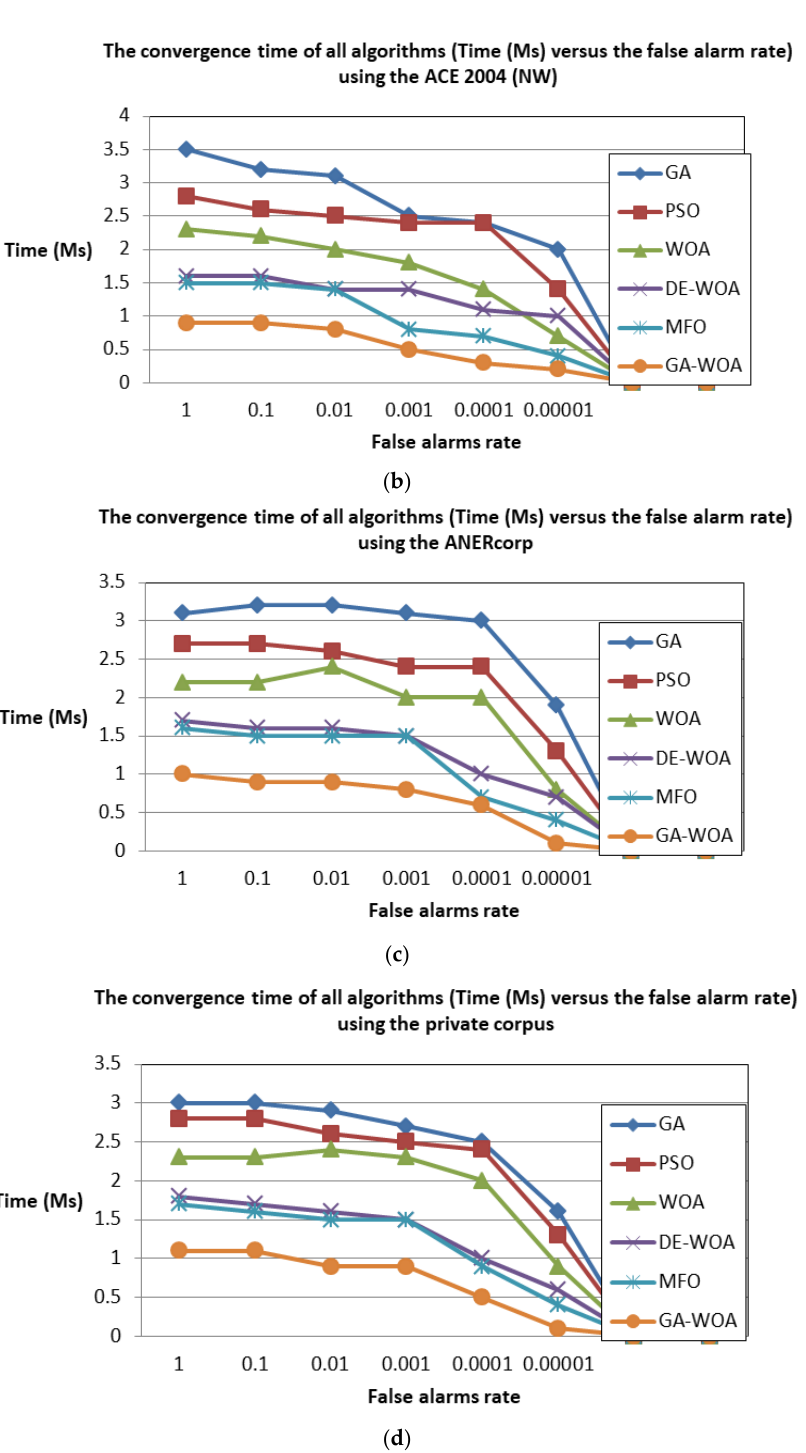
Figure A1. The convergence time versus the FAR rate for all algorithms using ( a ) ACE 2003 (NW), ( b ) ACE 2004 (NW), ( c ) ANERcorp, and ( d ) the private corpus. Cont. Table A7. Performance evaluation of ontology learning using the proposed G-WOA and the non- Arabic corpora.